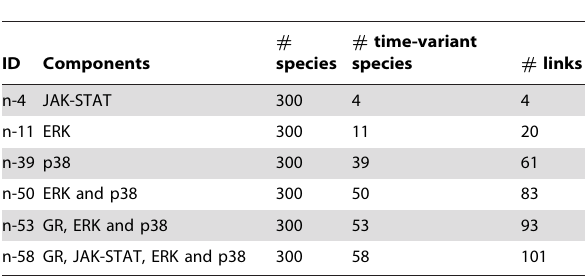
Table 1. Characteristics of the benchmark network set.